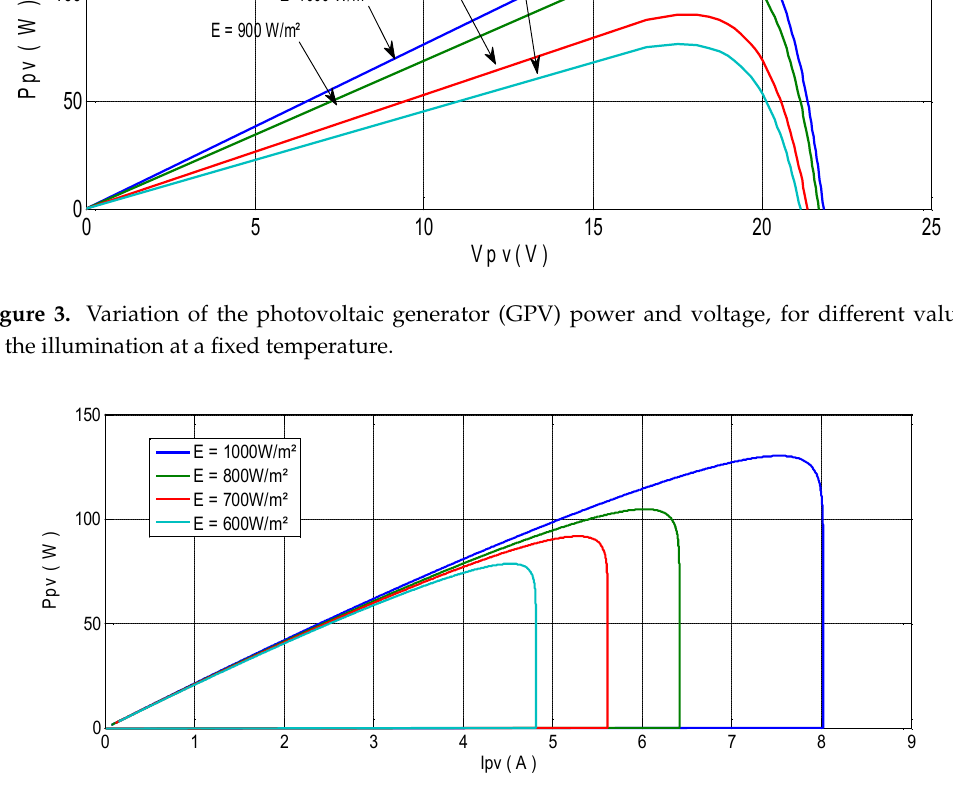
Figure 4. Variation of the GPV power and current, for different values of the illumination at a fixed temperature.